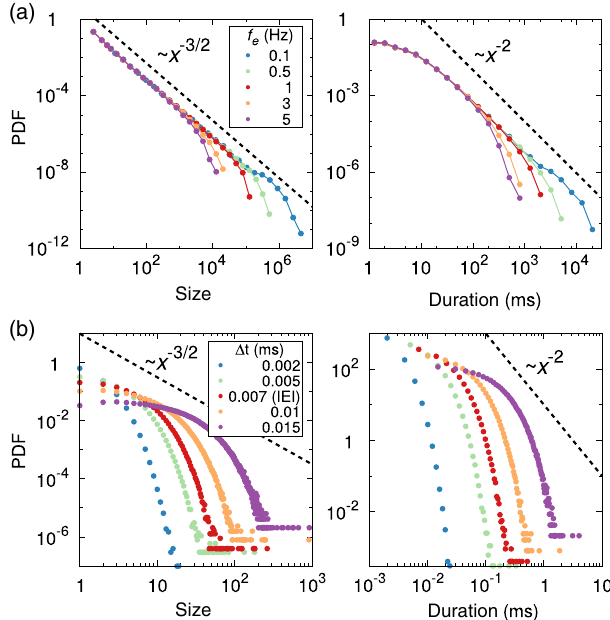
FIG. 2. Probability distribution functions (PDF) for the ava- lanche size and durations within the up-state phase in the model of Millman et al. [44] using two different methods (double logarithmic plot). (a) Causal avalanches were defined using the same criterion as in Ref. [44], for several values of the external input f e , confirming the observation that sizes and durations are power-law distributed with the same exponents of an unbiased branching process, i.e., τ ¼ 3 = 2 and α ¼ 2 , respectively [9,11]. (b) “ Time-correlated ” avalanches, defined with the standard temporal binning method [8] (which estimates causality by temporal proximity), using five different time intervals Δ t to bin the data, including one coinciding with the average interevent interval (IEI) as usually done in the analyses of empirical data [8], for f e ¼ 5 Hz; in this case, distributions do not obey a power-law distribution but have a characteristic scale. In all cases, simu- lations were performed in a network of N ¼ 3000 neurons (model parameters as in Ref. [44]; see Appendix